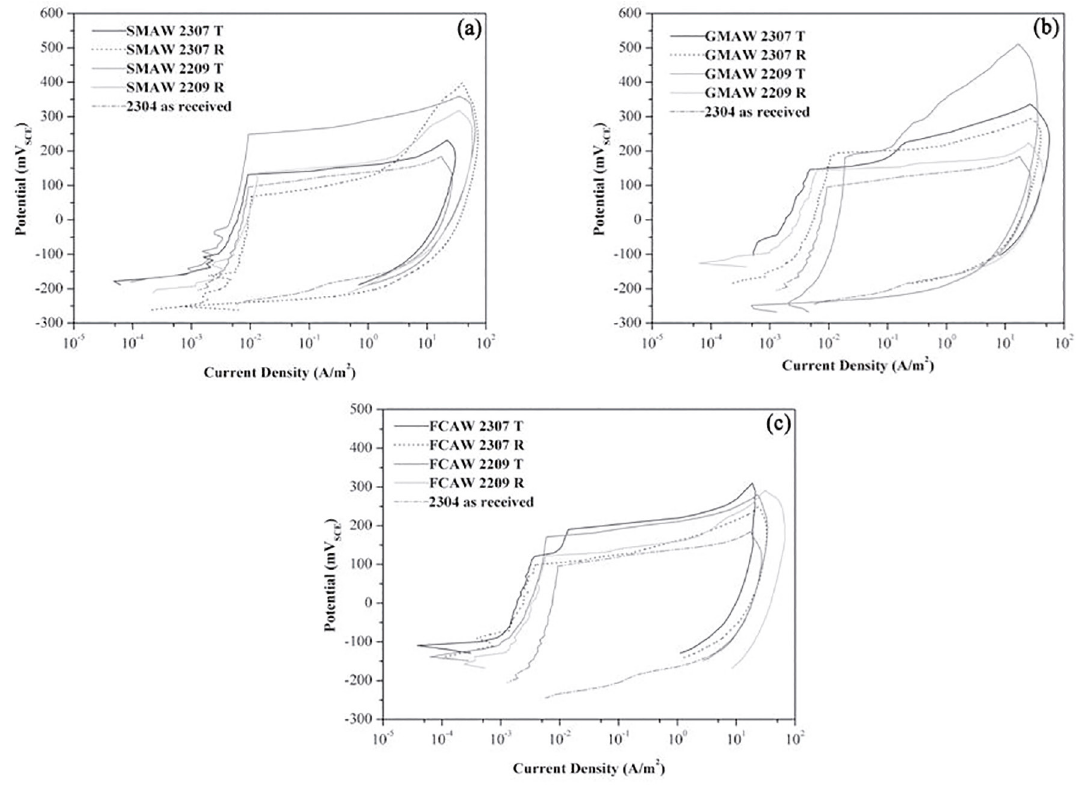
Figure 4: Cyclic potentiodynamic polarization curves for (a) SMAW (b) GMAW and (c) FCAW process. T – top of weld, R – root of weld